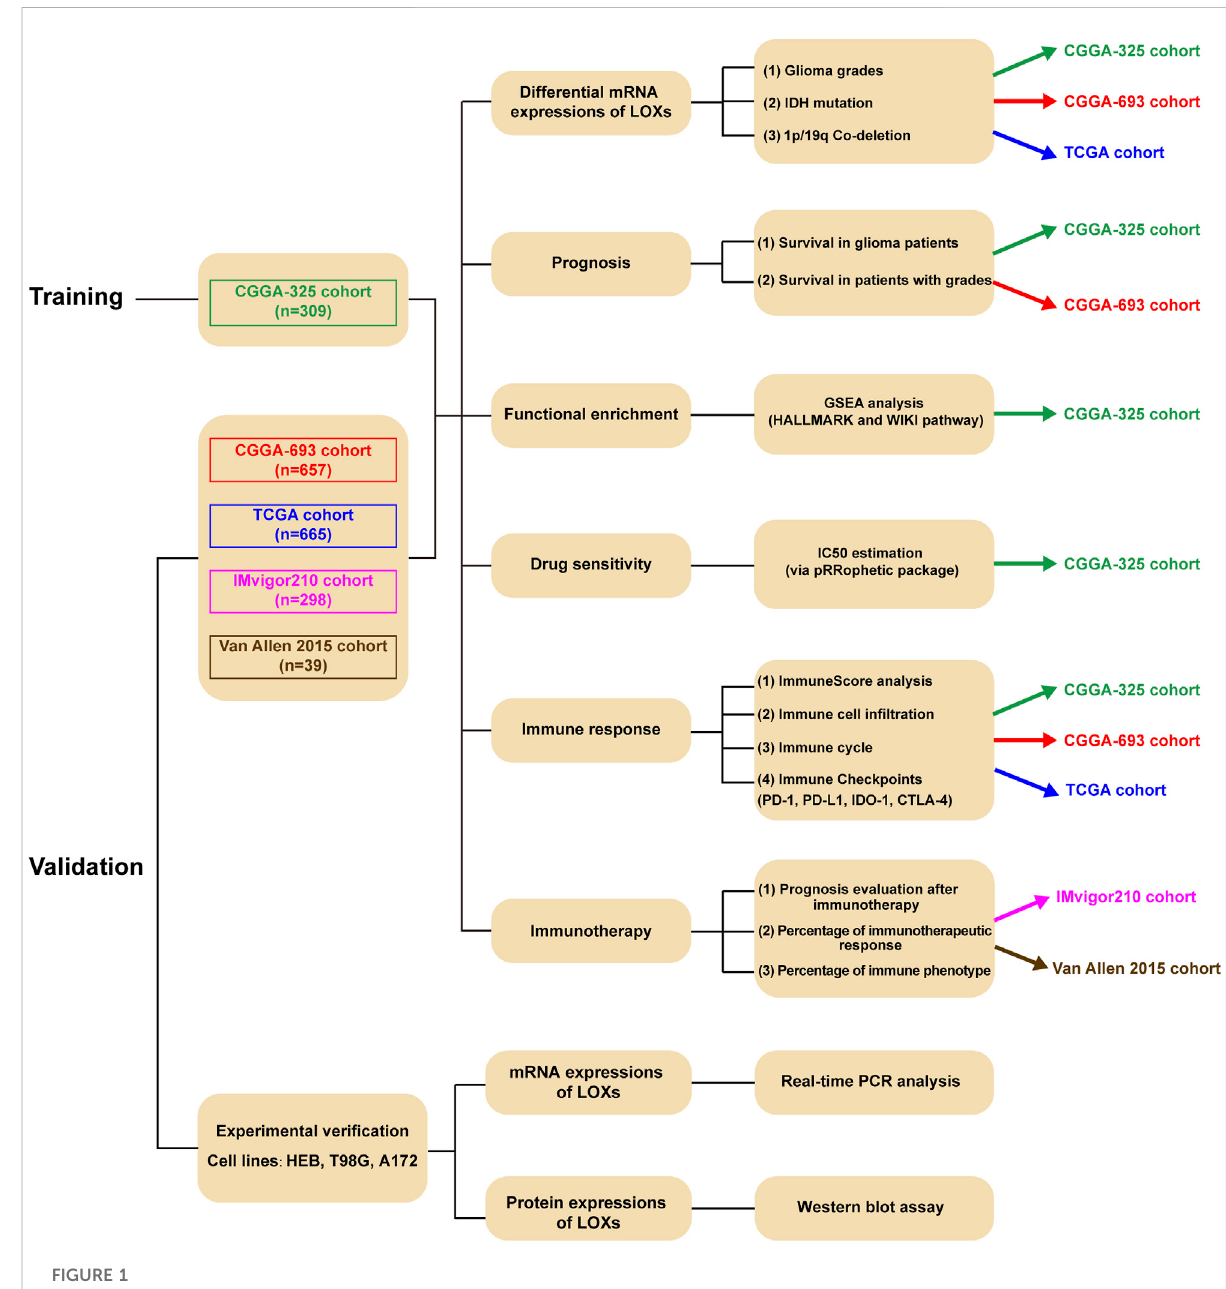
FIGURE 1 The work fl ow chart of our present